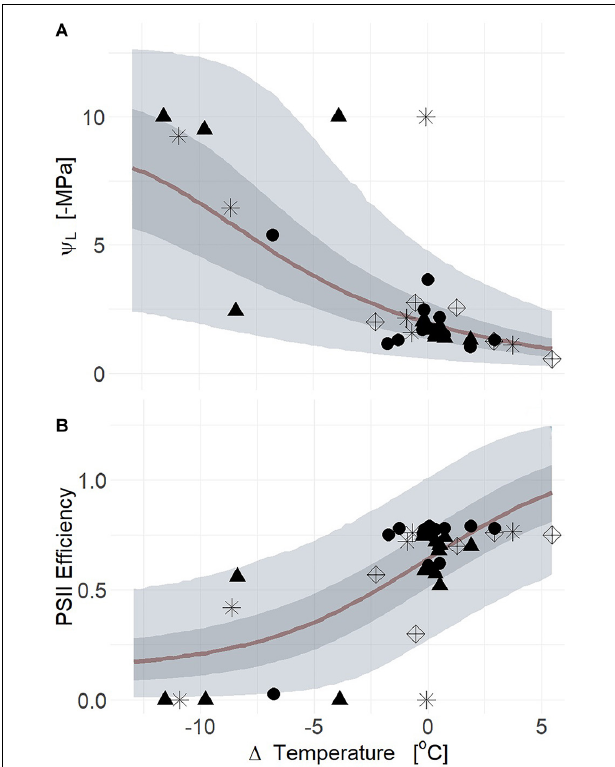
FIGURE 5 | Leaf water potential ( (cid:57) L ) response to changes in air temperature relative to leaf temperature ( deltaT , air minus leaf temperature) from both thermal radiometers and cameras (A) . Decreases of deltaT corresponding to greater tension on xylem for aspen (POTR, triangles), ponderosa pine (PIPO, circles), sagebrush (ARTR, star), and B. rapa (BRR5, diamonds) ( R 2 = 0.57). The decreases of deltaT was similarly associated with reductions of photosystem II efficiency ( F v (cid:48) /F m (cid:48) ) (B) across all species ( R 2 = 0.56). Maximum likelihood estimates (MLE, red) are presented and the 50% (dark gray) and 94% (light gray) creditable